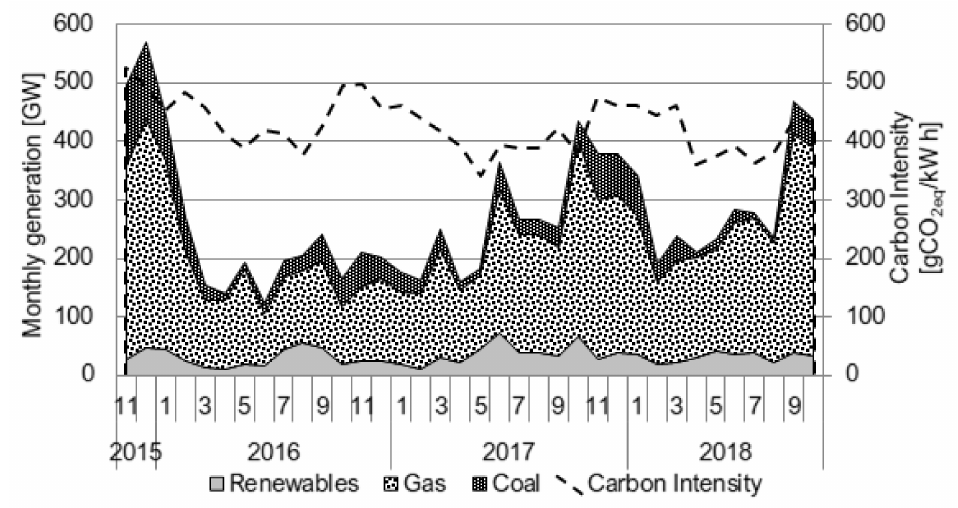
Figure 6. Active generation provided by the BM in PAR50 period per fuel and CI. Data source: [54].